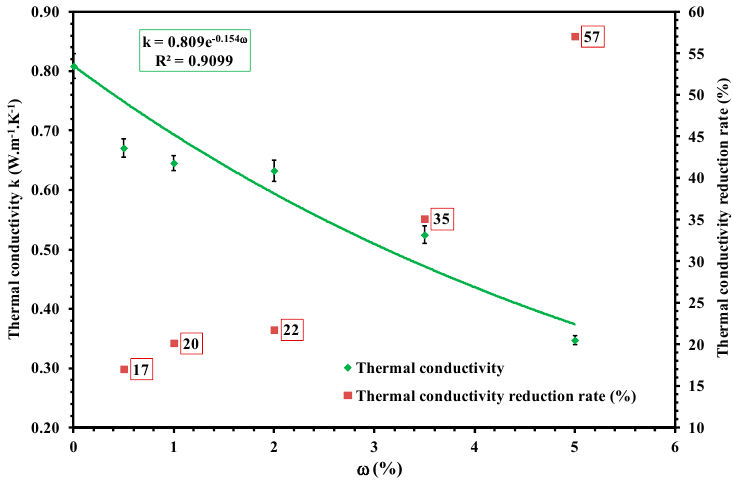
Figure 8. Thermal conductivity (primary axis) and its reduction rate (secondary axis) as function of AF mass content. Measurements uncertainty is below 2.9%.